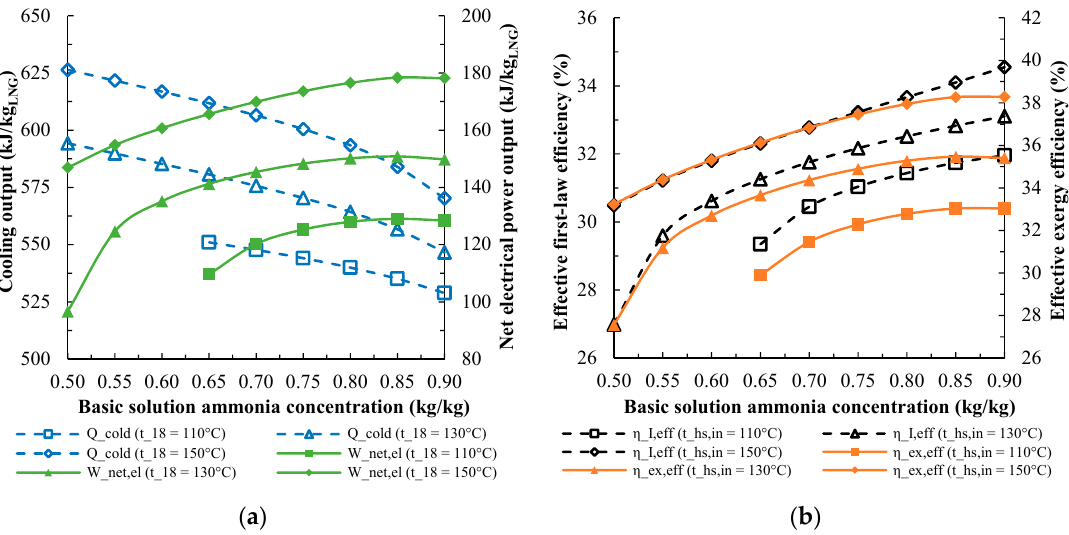
Figure 4. E ff ect of the KC sub-system basic solution ammonia concentration on poly-generation system performance at di ff erent heat source inlet temperatures ( t 18 = 110 ◦ C, 130 ◦ C, and 150 ◦ C): ( a ) Useful cooling and electrical power outputs; ( b ) Overall efficiencies.